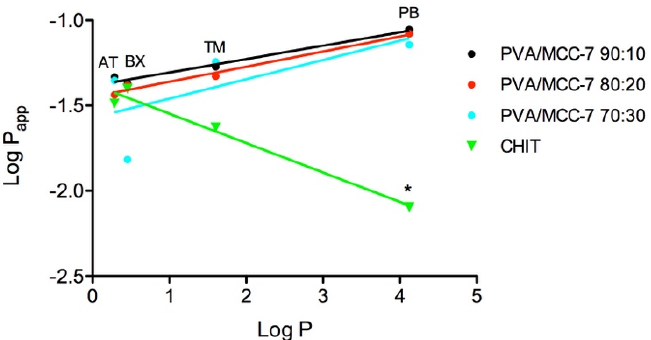
Figure 9. Relationship between the logarithmic values of partition coefficient (P) of the model drugs and their apparent permeability (P app ) across different hydrogels. AT: atenolol; BX: betaxolol; TM: timolol; PB: penbutolol. * Statistically different from the other P app values of BX.